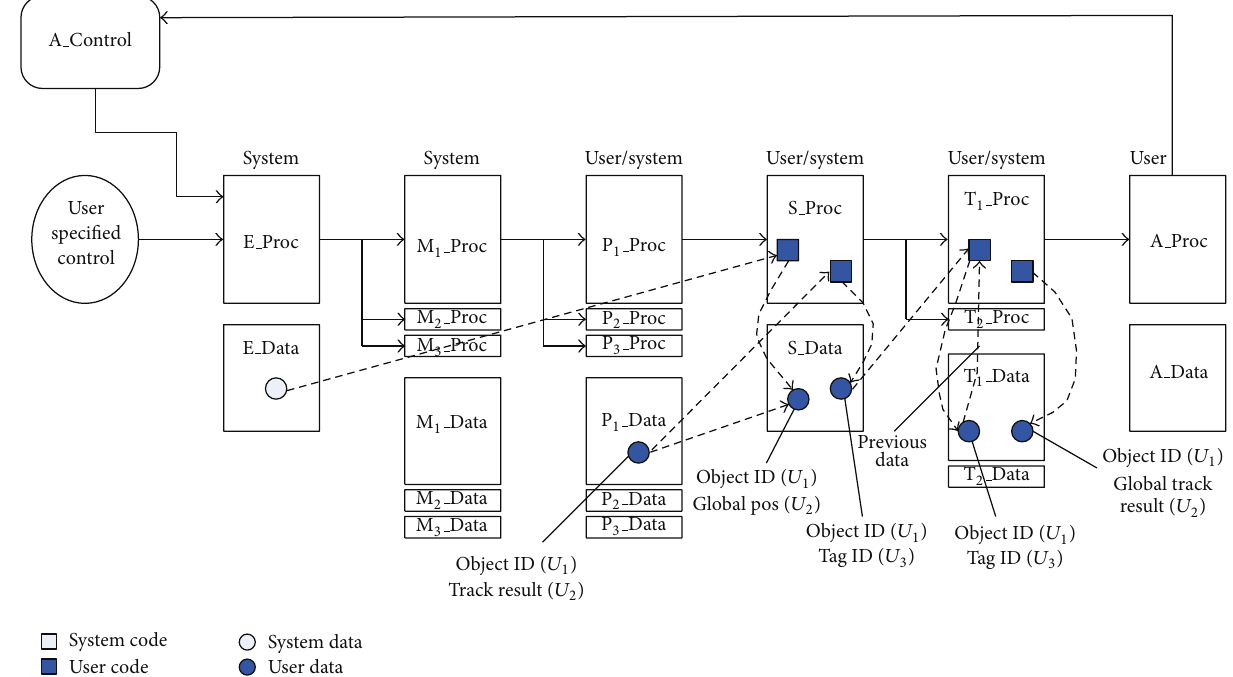
Figure 12: Illustration of modeling the execution behaviors where user codes are additionally defined for the realistic application modeling.